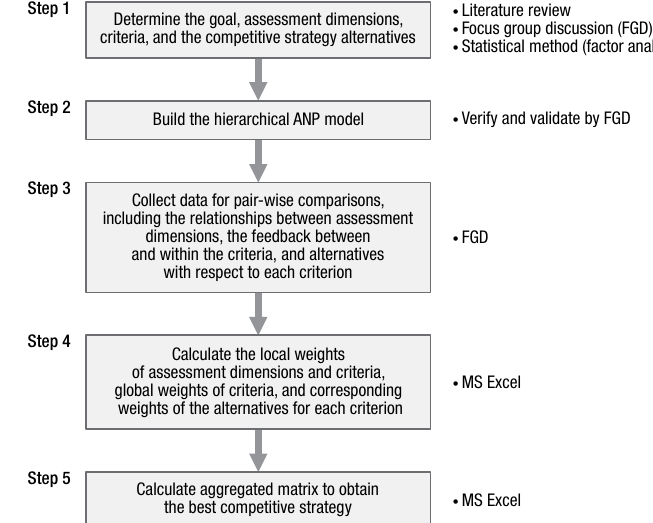
Fig. 3. The proposed research process for selecting the best competitive strategy alternative